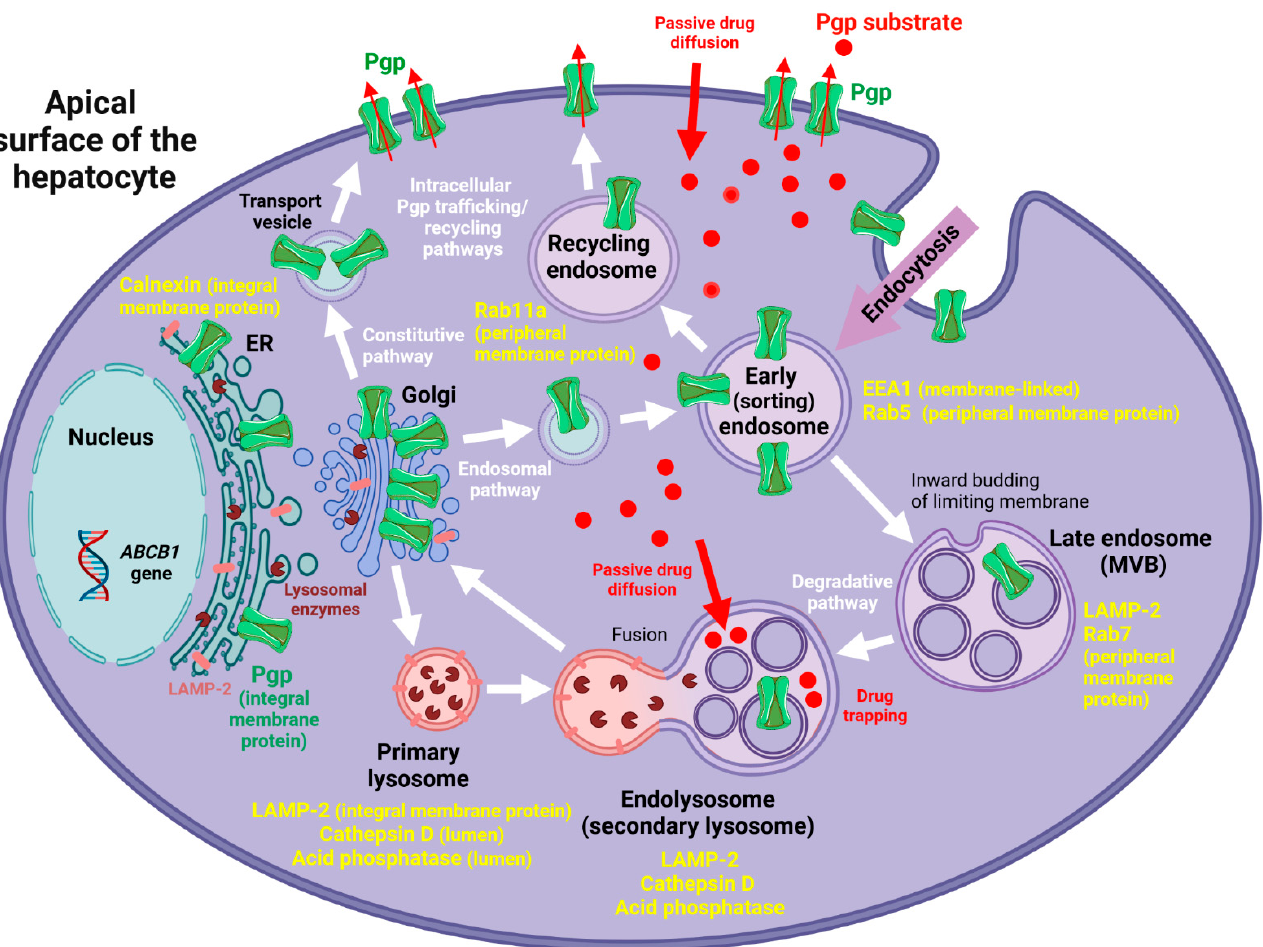
Figure 9. Schematic illustration of synthesis, trafficking, recycling, and degradation of Pgp in a hepatocyte (based on Fu [16] and Löscher and Gericke [6]). Additionally, major steps in the formation of endosomes and lysosomes are shown. Organelle markers are shown in yellow. In addition, passive drug diffusion into the cell and drug trapping of weak-base lipophilic agents (such as doxorubicin) by endolysosomes is illustrated. Please note that the lysosomal enzyme acid phosphatase also occurs in endosomes [25,41], which is not illustrated. At least in part, this enzyme is transported via a constitutive pathway from Golgi via the cell membrane to endosomes and endolysosomes [42,43], which is not illustrated either. A similar constitutive pathway also exists for LAMP-2 [48,49], so transport vesicles and endosomes may contain this membrane protein (not illustrated). The figure was created with BioRender.com (accessed on 7 April 2022).